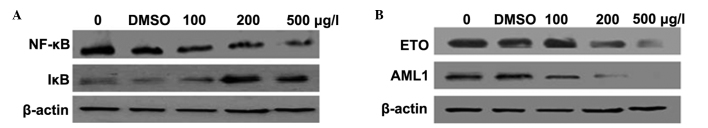
ZGDHu-1 downregulates the expression of NF-κB and upregulates the expression of IκB, causing degradation of the A/E fusion protein (A) Effect of ZGDHu-1 on NF-κB and IκB. There was a negative control with no drugs and a DMSO control. β-actin was used as a loading control. (B) Protein levels of the A/E fusion gene following treatment with ZGDHu-1. Western blot analysis was used to detect changes in these genes. β-actin was used as a loading control. ZGDHu-1, N,N′-di-(m-methylphenyi)-3,6-dimethyl-1,4-dihydro-1,2,4,5-tetrazine-1,4-dicarboamide; NF-κB, nuclear factor-κB; DMSO, dimethyl sulfoxide; AE, AML1/ETO.